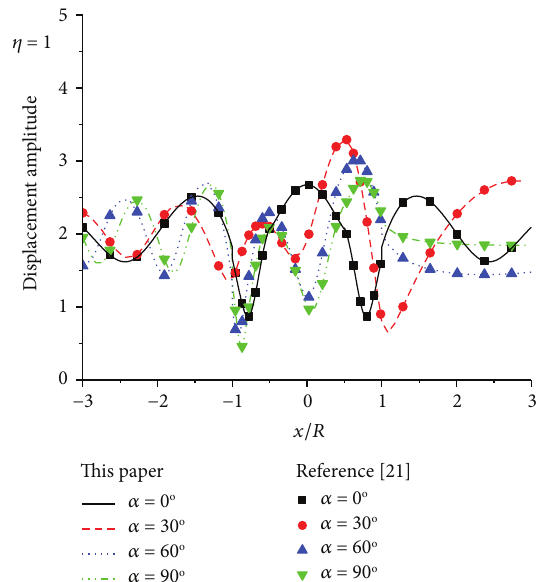
Figure 4: Surface displacement amplitude of degraded isosceles trapezoid